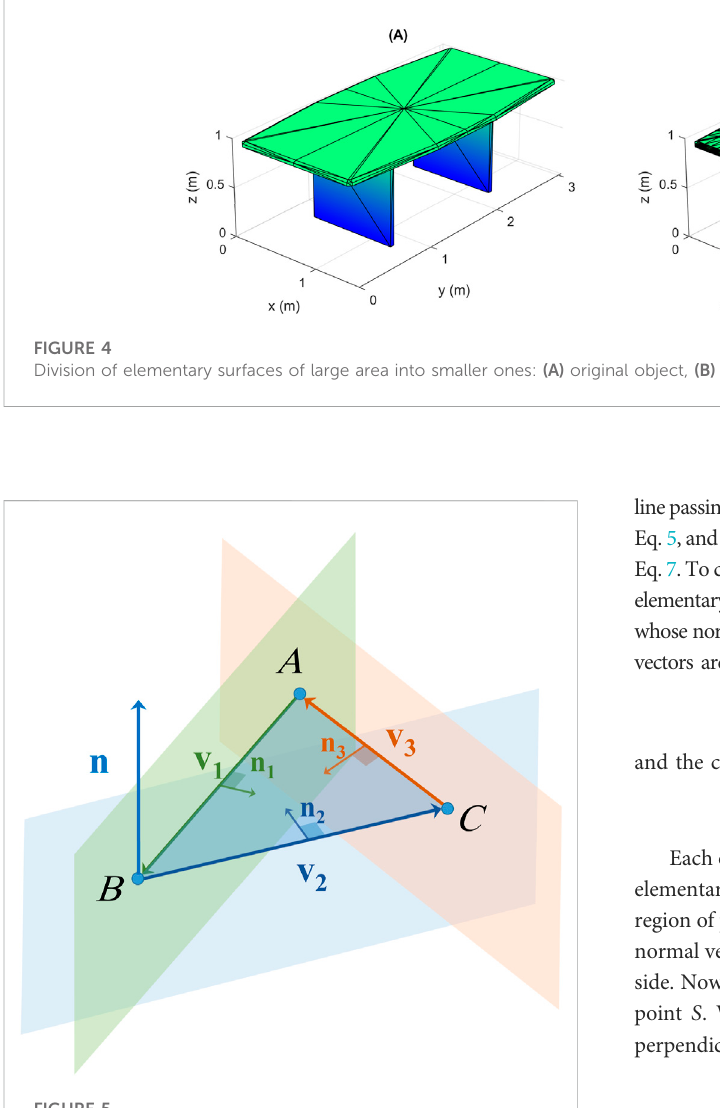
FIGURE 5 An illustration of the three perpendicular planes of an elementary